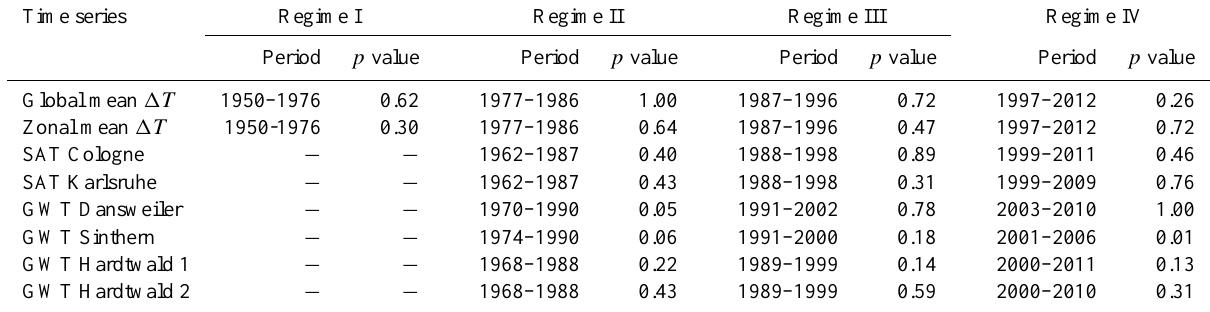
Table 5. Results ( p values) of the Mann–Kendall test for the absence of a trend for all regimes in SAT and GWT time series.